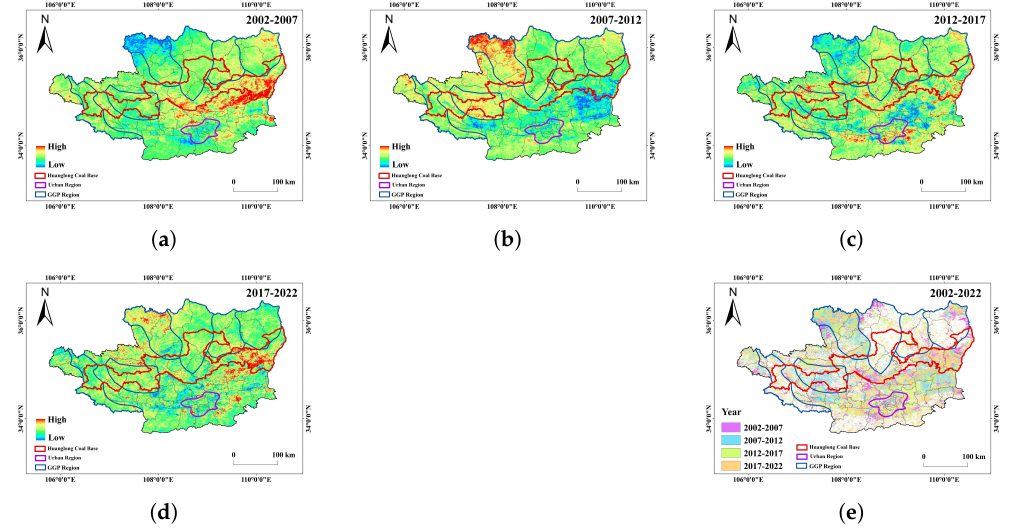
Figure 7. Variation magnitude map of the RSEI in the study area: ( a ) variation in 2002–2007, ( b ) vari- ation in 2007–2012, ( c ) variation in 2012–2017, ( d ) variation in 2017–2022, and ( e ) variation intensity map of